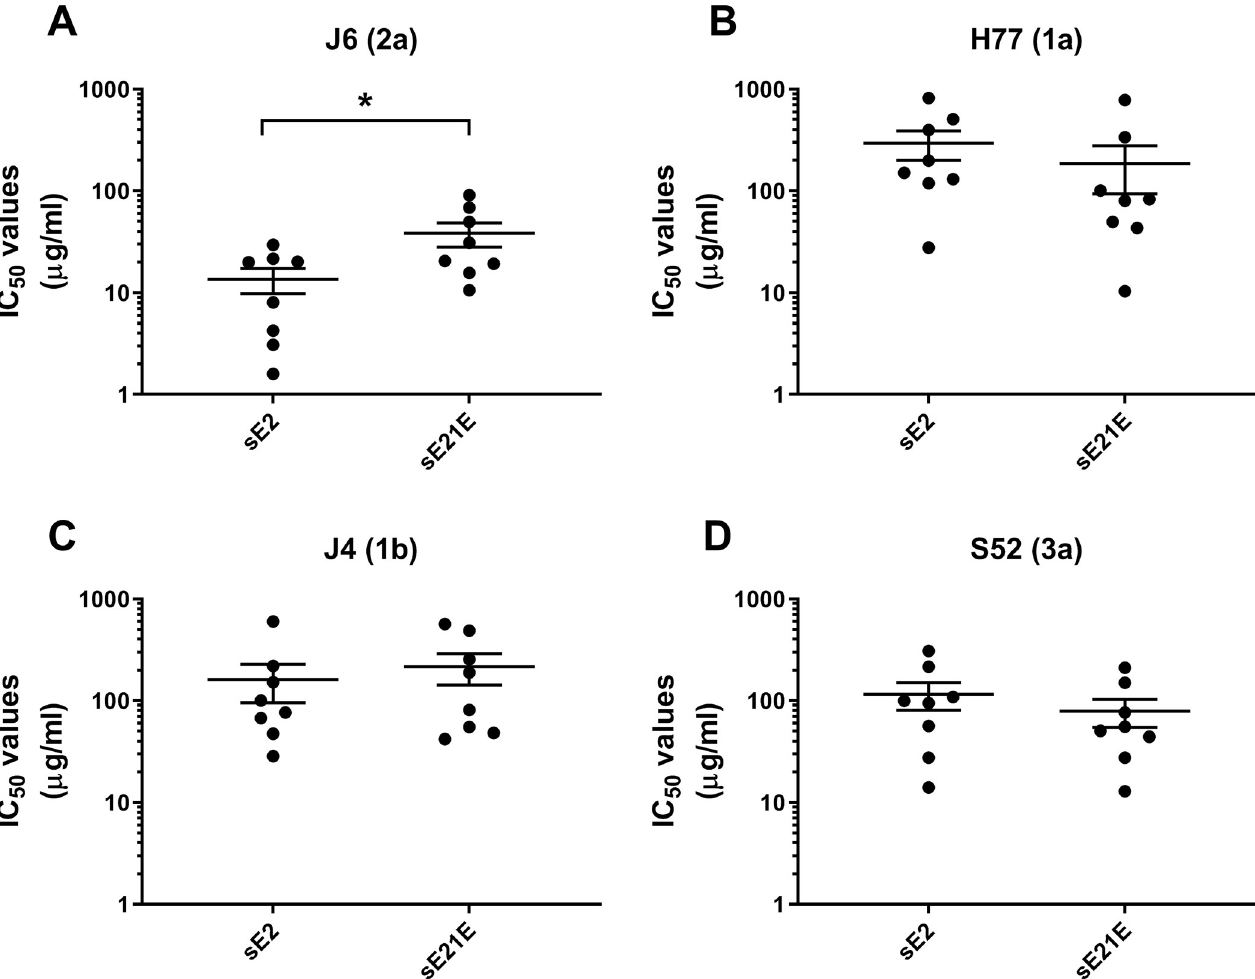
Fig 4. Comparing the ability of sE21E and sE2 to induce HCV NAbs in mice. 8–10 week-old BALB/c mice were immunized with either sE21E or sE2 with HIS tags in AddaVax adjuvant and subsequently boosted twice with 3 week intervals. Mouse antibodies were obtained from full bleeds, as described in Fig 3. HCV NAbs were measured against HCVcc of isolates A) J6 (2a, autologous neutralization), B) H77 (1a, heterologous neutralization), C) J4 (1b, heterologous neutralization), and D) S52 (3a, heterologous neutralization) in dose-response neutralization assays. IC 50 values were calculated based on four parameter sigmoidal dose-response curves (Graphpad PRISM 8.0.0). Statistical significance of the differences between groups was assessed for each virus in two-tailed, unpaired t-tests at the 95% significance level. � , Neutralization efficacy of mouse antibodies from animals immunized with sE21E or sE2 were statistically significantly different for the indicated virus. No data points were excluded from the